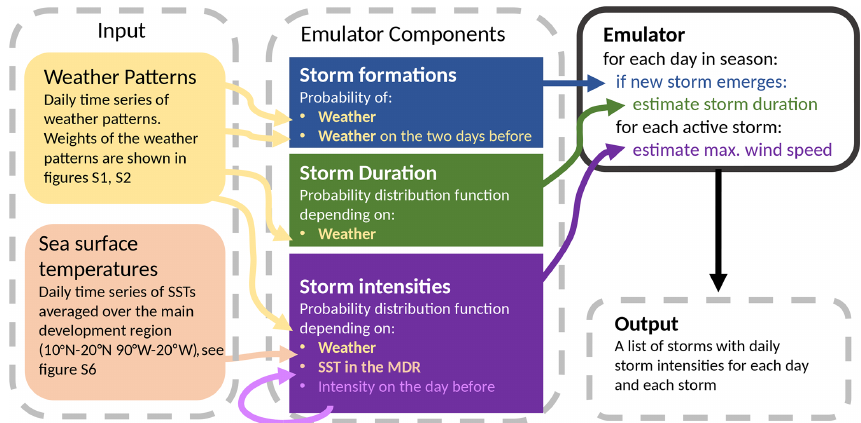
Figure 2. Schematic overview of the emulator. The input required to emulate TC seasons is shown on the left side. In the center, the three components of the emulator are listed. On the right side, the functioning of the emulator is shown and the format of the output is indicated. Arrows between the left-hand columns indicate which input is used in which components of the emulator. The light-purple arrow indicates that the estimation of storm intensities depends on the previous intensity of a